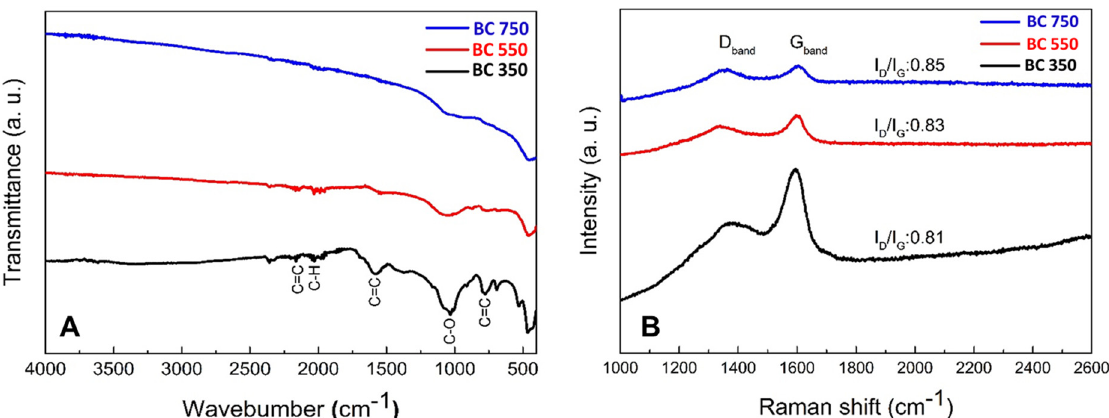
Figure 1. Fourier-transform infrared spectroscopy (FTIR) ( A ) and Raman spectra ( B ) of sugarcane straw biochar (BC) produced at pyrolysis temperatures of 350, 550 and 750 °C.